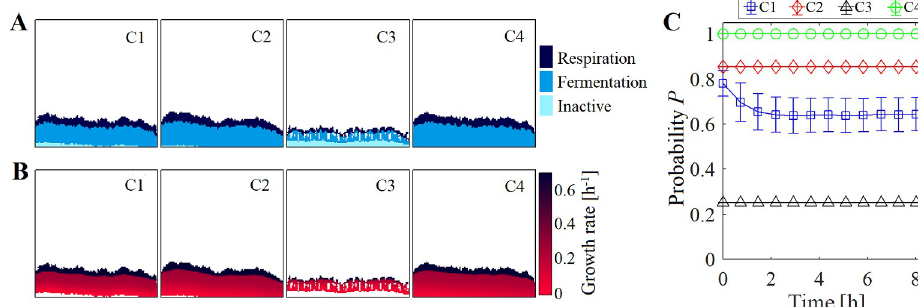
Fig 1. Formation of the E . coli biofilm with a glucose supply of 2.25 mM using a square lattice. (A) Phenotype distribution and (B) growth-rate gradients predicted for the E . coli biofilm at 3.7 h under the crowding assumptions C1-4 (Table 2). Phenotypes identified were respiration: glucose + O 2 ➔ (acetate) + biomass, fermentation: glucose ➔ acetate + biomass, and inactive cells. Some cavities were observed inside the biofilm in C3 simulations due to the slow growth rate of the cells and the stochastic movements during the shoving process. (C) Probability P to find available space for glucose diffusion in biofilm-boxes computed at different times. Error bars show the standard deviation in three independent